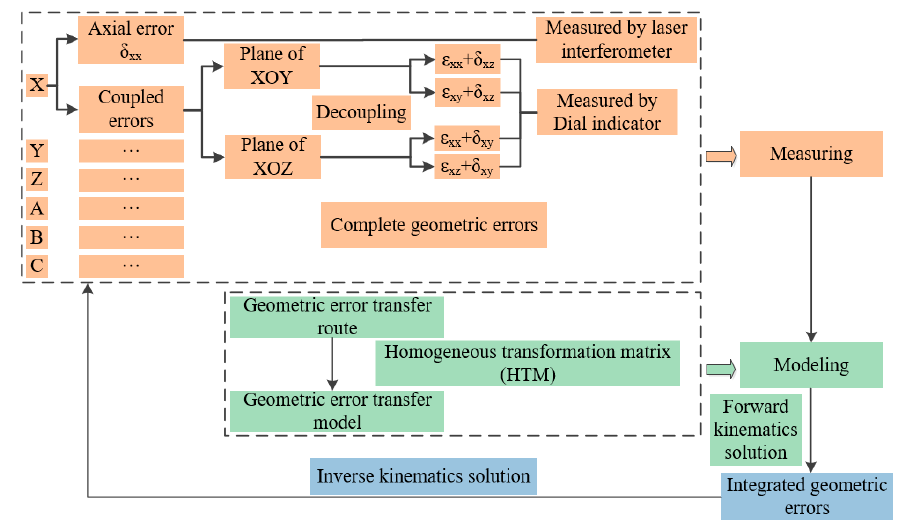
Figure 1. Flow chart of the coupling and decoupling measurement method.